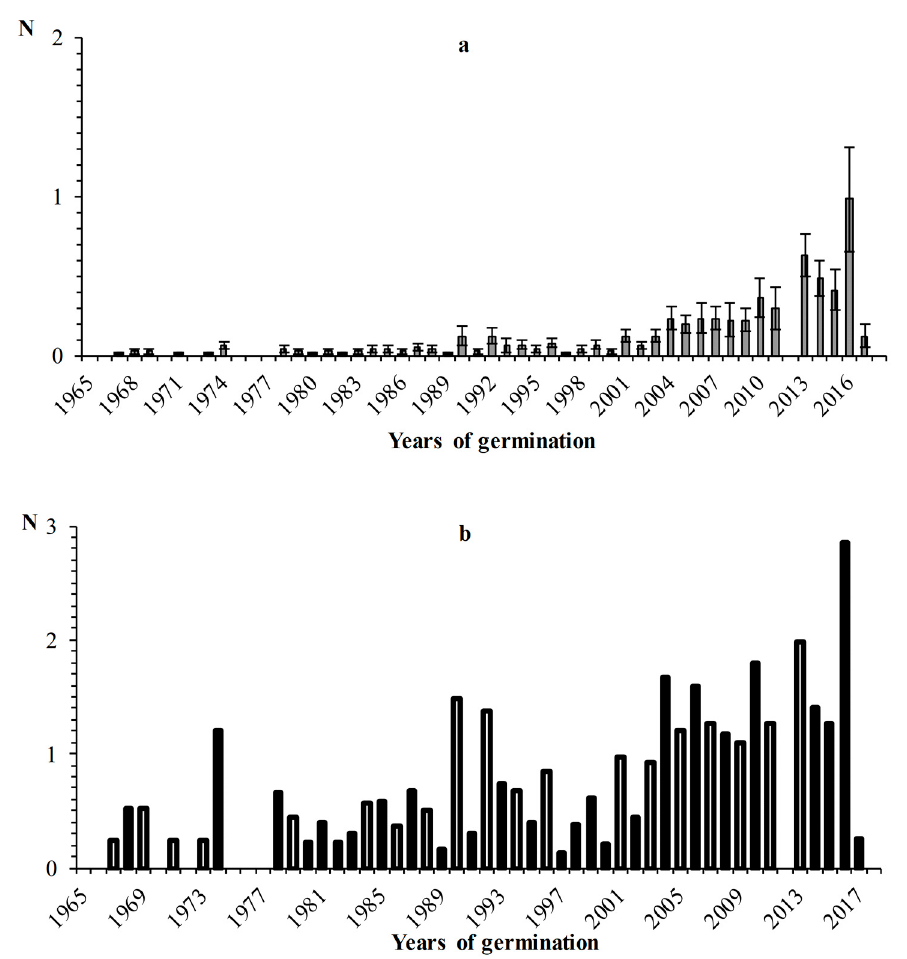
Figure 3. Trend in the Pinus sibirica regeneration on the mountain tundra plateau: ( a ) Number of undergrowth (N) (thousand specimens per ha) with an average error ( ± m); ( b ) remodeled number of seedlings that appeared initially (N), thousand per ha.